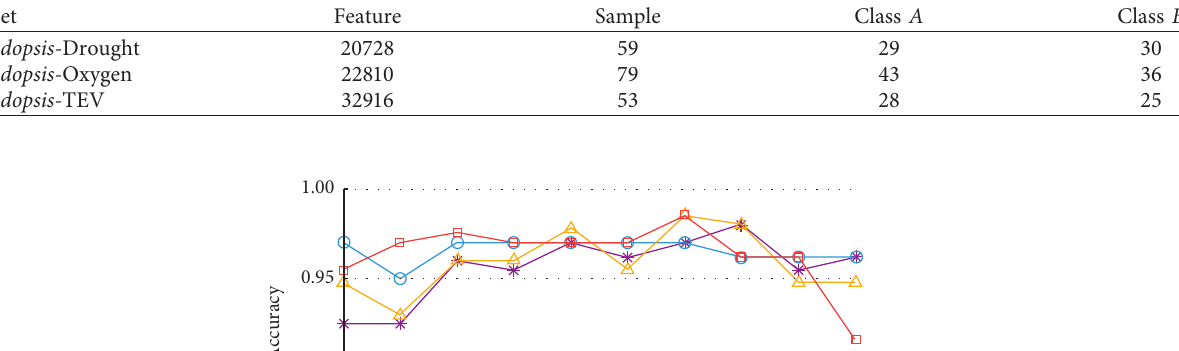
Table 2: Detailed information about the three Arabidopsis thaliana datasets.